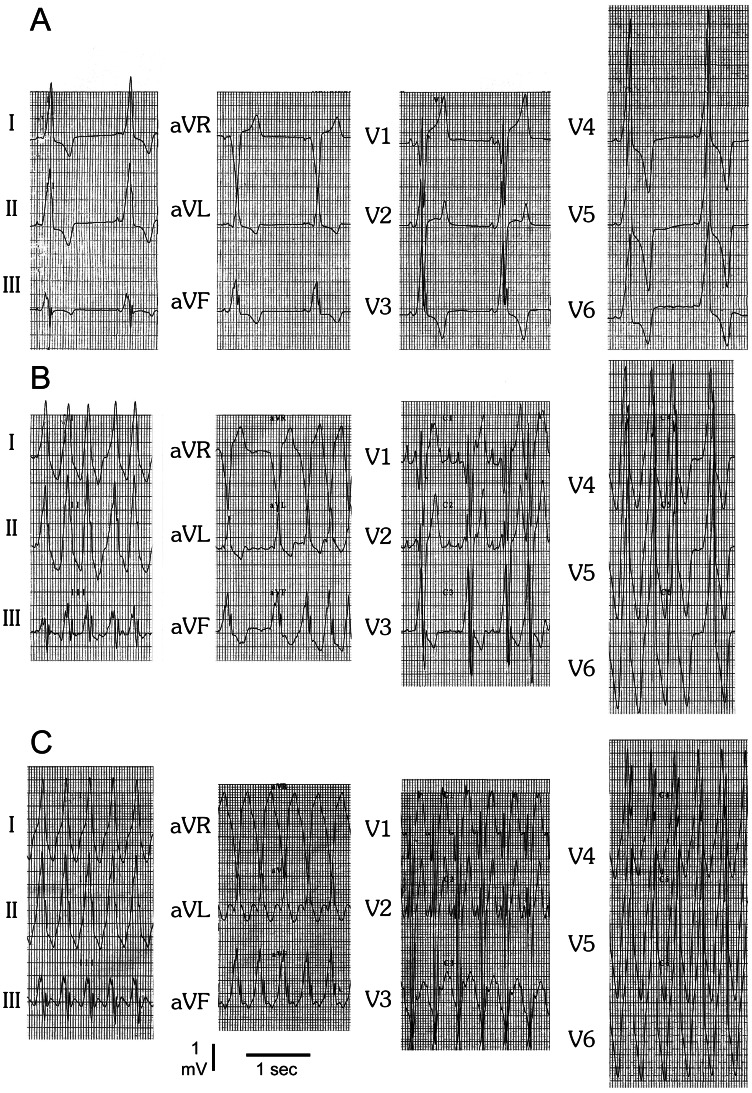
ECGs (25 mm/s, 5 mm/mV) of the proband at age 19.(A) Resting ECG shows sinus bradycardia, ventricular preexcitation and significant left ventrical hypertrophy. (B) Irregularity of the rhythm, rapid ventricular response, delta waves, and wide, bizarre QRS complexes with beat-to-beat variations in configuration, strongly suggesting the diagnosis of combined AF and WPW. (C) Regular wide QRS complex tachycardia, most likely due to antidromic atrioventricular reentry tachycardia (AVRT), suggesting that the accessory connection is capable of sustaining reentry and participating in reciprocating tachycardias.